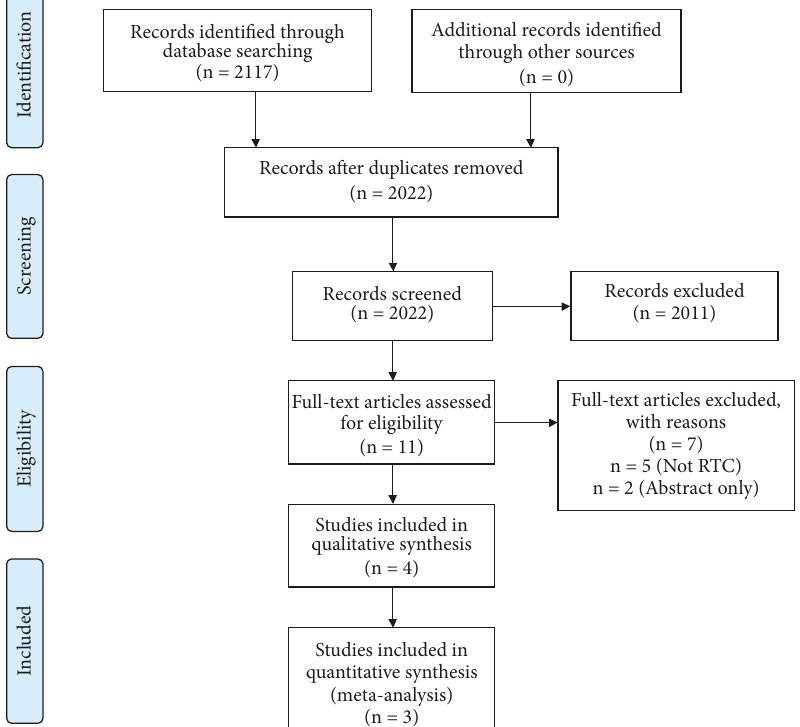
Figure 1: PRISMA flowchart of literature